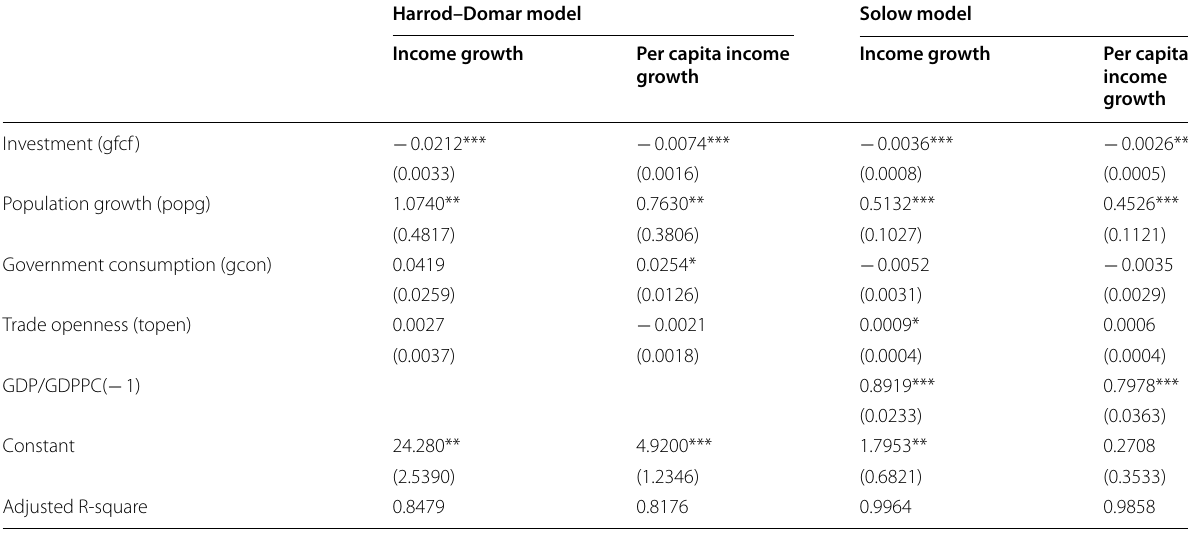
Values in brackets are standard errors *** ,** and * represent statistical significance level at 1%, 5% and 10%, respectively. The values in parenthesis “[]” show the non-acceptance of the null hypothesis at 5%